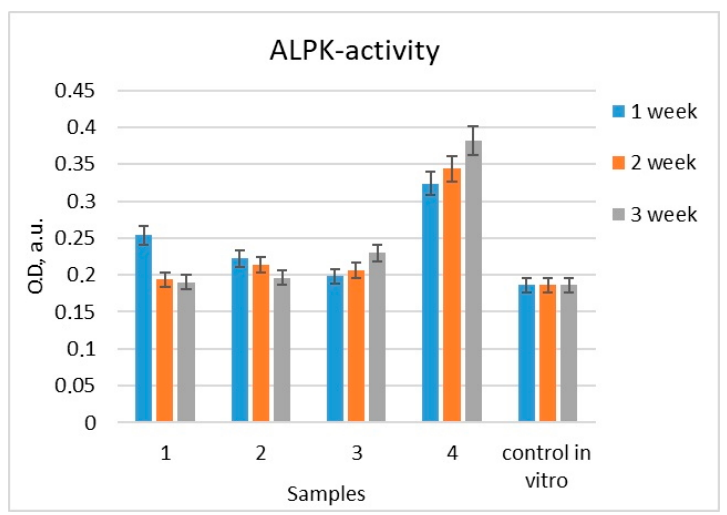
Figure 10. Changes in the level of alkaline phosphatase activity during differentiation of the MG-63 line in the osteogenic direction. ( Note: Control in vitro is the cultivation of cells on the surface of plastic. The level of ALP activity in the medium from control cells was taken as 100% [cultivation on plastic].)